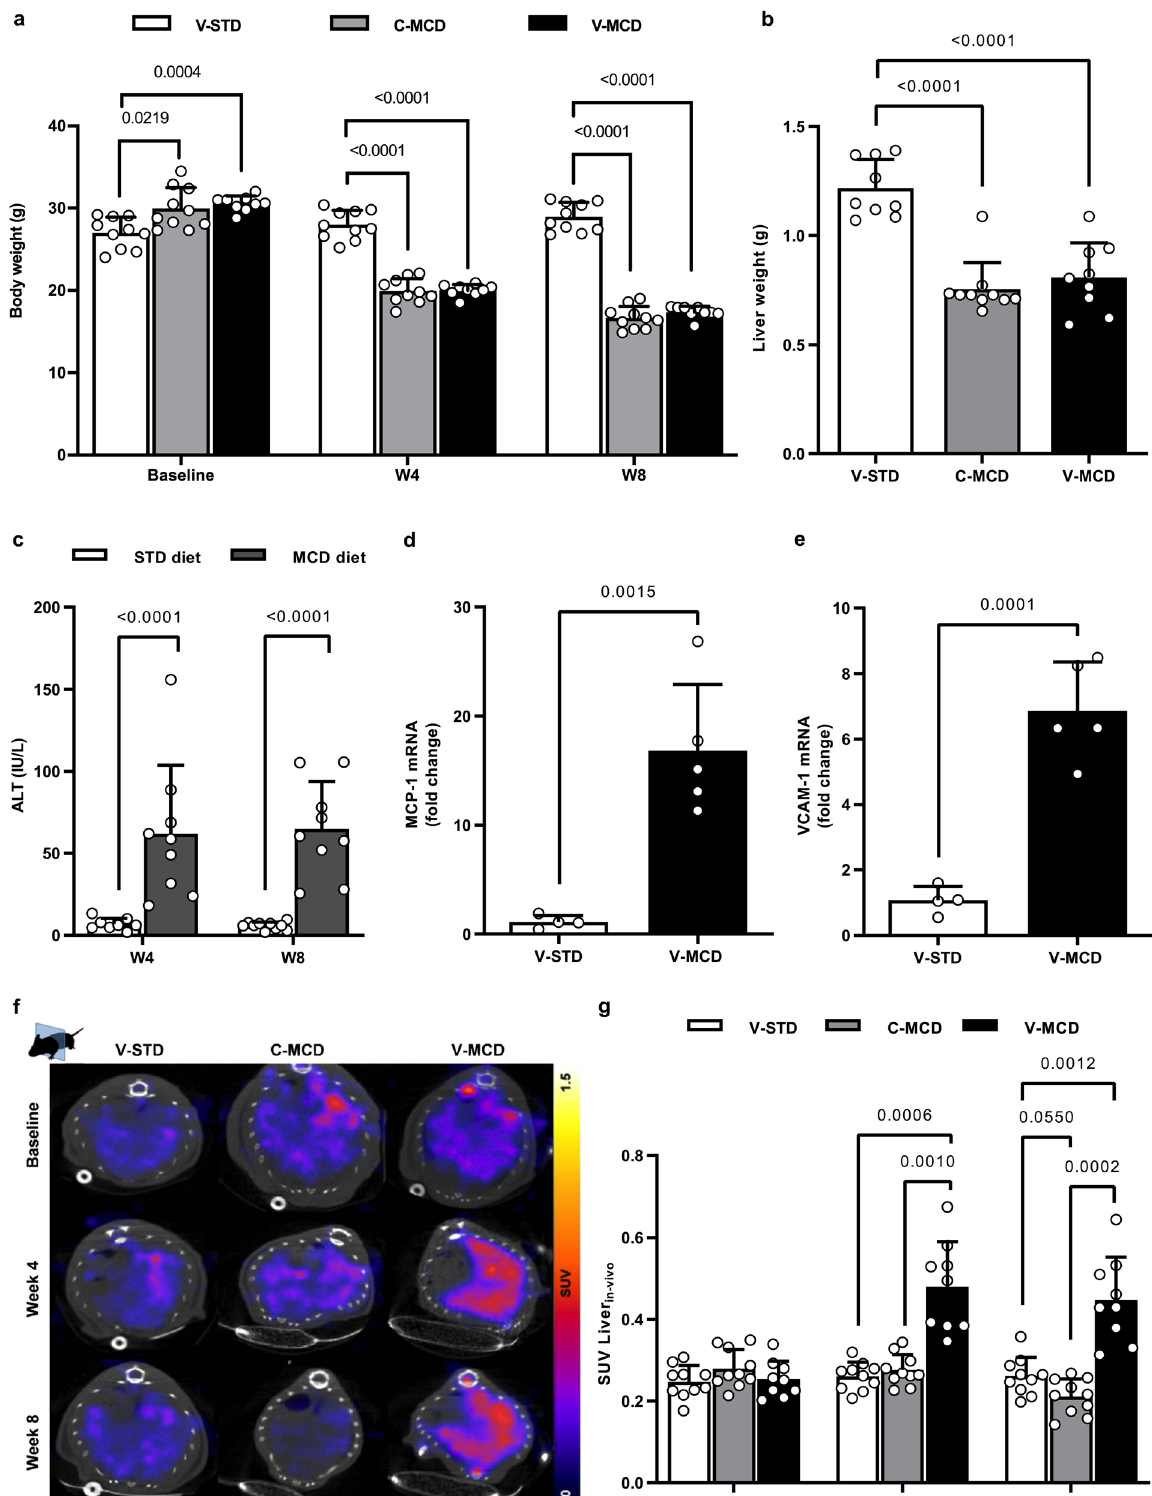
99m Tc-cAbVCAM1-5 (V-MCD). f Representative SPECT-CT liver imaging with 99m Tc- cAbVCAM1-5 or 99m Tc-Control at baseline, 4 and 8 weeks; transversal sections and g SPECT quanti fi cation in SUV (C-MCD & V-STD mice ( n =10), and V-MCD mice ( n =9); two-way ANOVA). All data are represented as mean±SD and signi fi cant p values(correctedformultipletestingusingTukey ’ sposthocwhenmorethantwo groups were compared) are given above the bars. Source data are provided as a Source Data fi le.